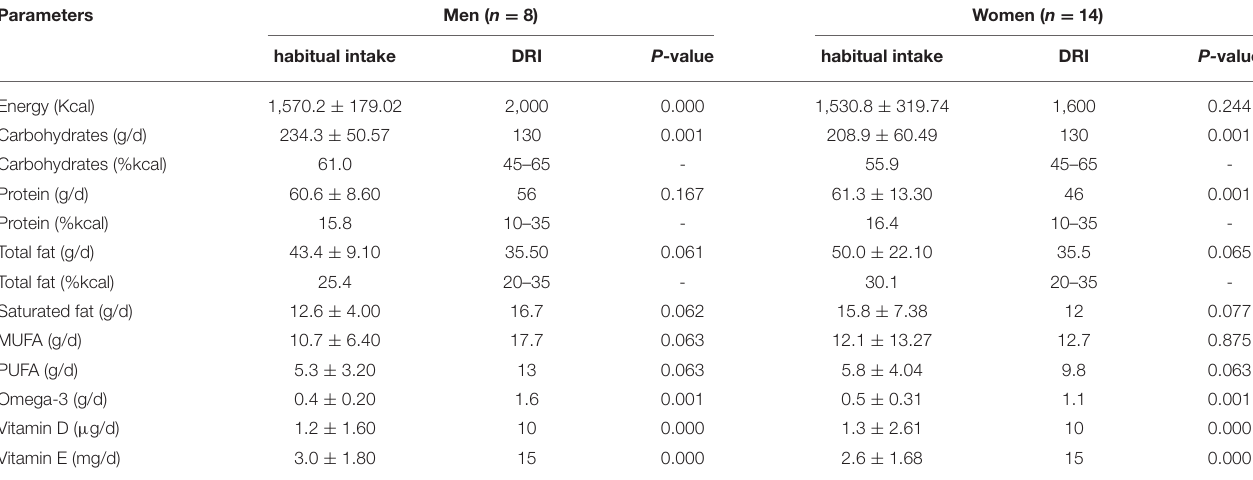
TABLE 2 | The habitual dietary intake of the study participants compared with DRI values among sex groups.